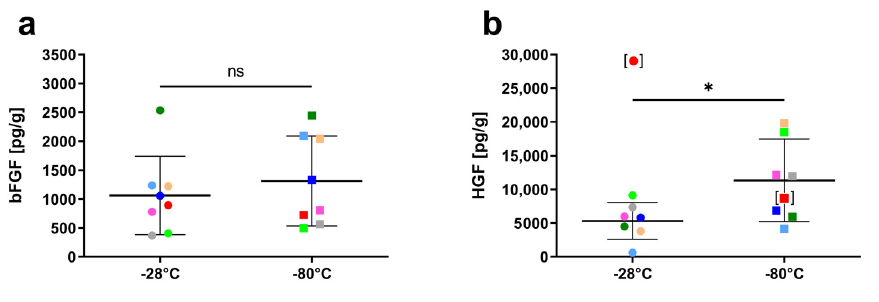
Figure 4. Growth factor levels of basic fibroblast growth factor (bFGF, ( a )) and hepatocyte growth factor (HGF, ( b )) after storage at -28 °C and -80 °C, respectively. Horizontal bars show mean values ± standard deviation. Pairs from the same donor are shown in matching colors. ns: Not statistically significant; Asterisk: p < 0.05; [ ]: Outlier excluded from statistical analysis.